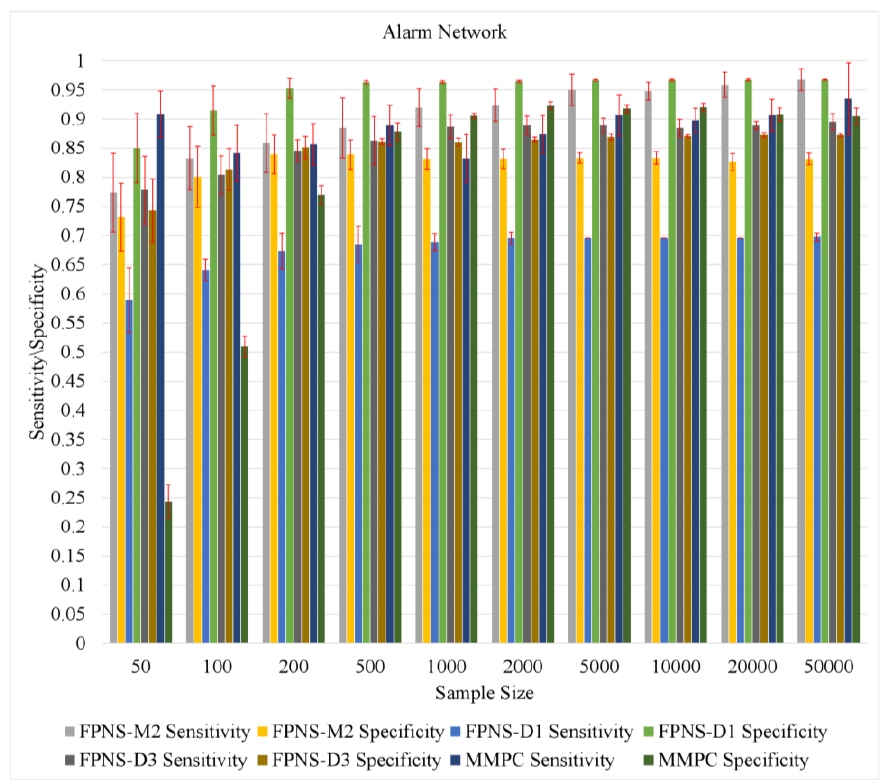
Figure 5. The sensitivity and specificity results in the alarm network.